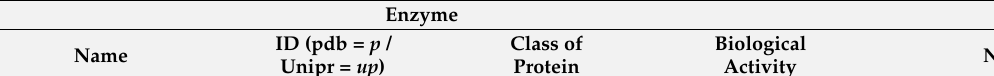
Table 3. Molecular docking of Cannabis sativa L.